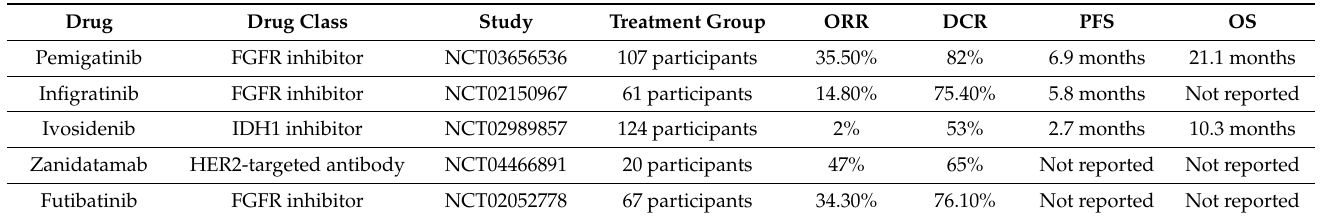
Table 1. Relevant clinical studies for targeted therapies with FDA approval or breakthrough therapy designation for